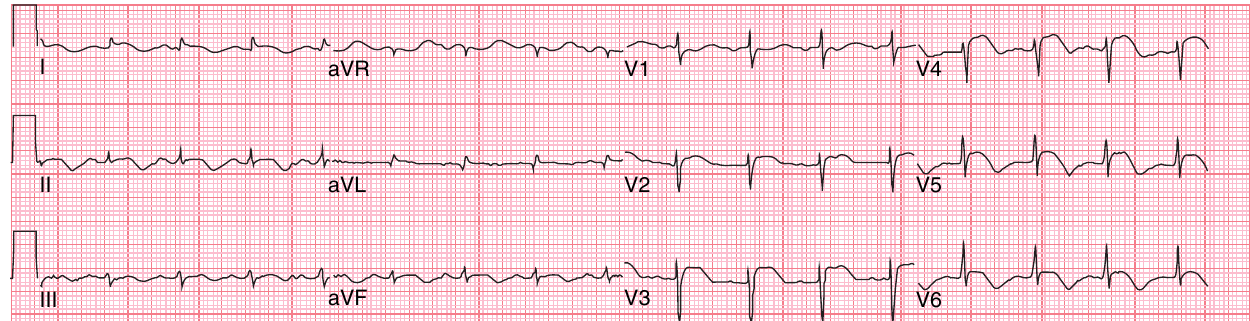
Figure 1. Electrocardiogram showing ST elevations in I, avL and V3–V6.